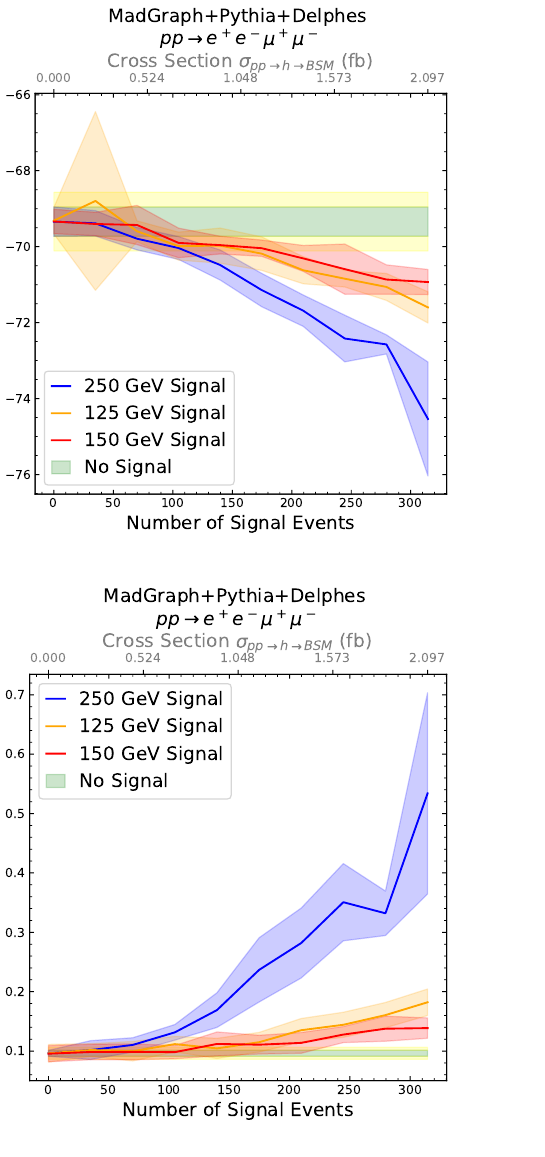
Figure 3 . MLC Loss. Same as figure 2, but zoomed in by a factor of 10 on the horizontal axis. The 95% exclusion limits approximately correspond to where the lines for each signal cross the yellow 2 σ band for the background-only